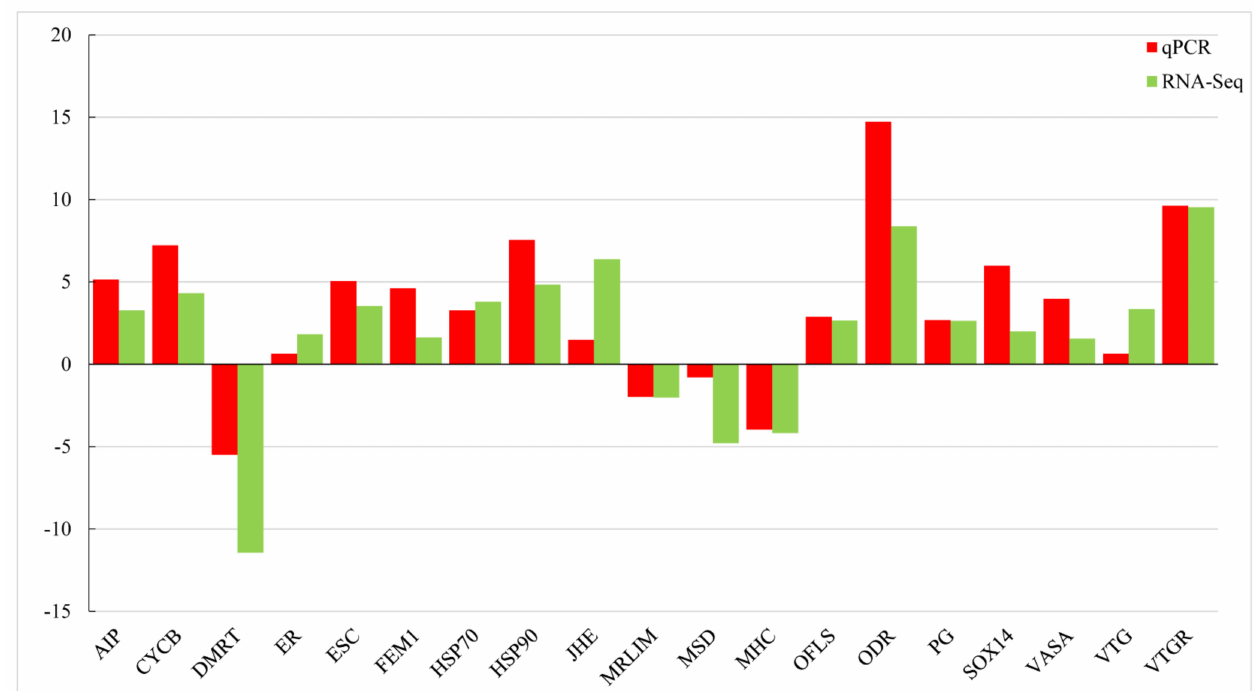
Figure 4. Candidate unigene expression levels revealed by qRT-PCR (red bar) and RNA-seq (green bar). n = 4 for each sex, the results of qRT-PCR were performed by relative expression using 18S rRNA as the reference gene and measured by the method of optimized comparative Ct (2 − ∆∆ Ct ) value, the qRT-PCR results were performed by log 2 (female/male) and the RNA-seq results by log 2 (female FKPM/male FKPM). They are showing the same expression